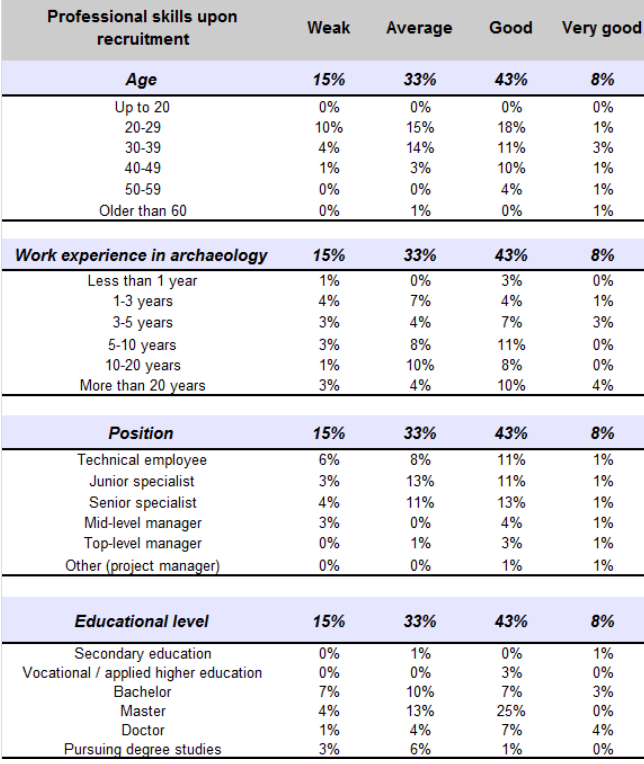
Table 20 - Professional skills and employee